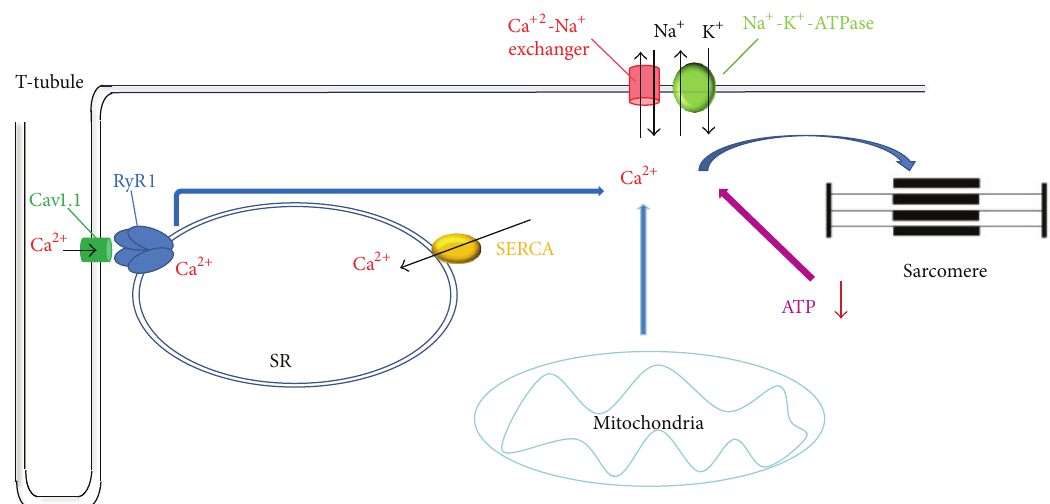
Figure 1: Schematic representation of a skeletal muscle cell and of Ca 2+ and Na + ion fluxes across the sarcolemma and sarcoplasmic reticulum (SR). Activation of Cav1.1 by membrane depolarization causes the RyR1 channel to open and to release Ca 2+ from SR, thus triggering muscle contraction. Ca 2+ concentration is regulated by the Ca 2+ -ATPase membrane pump (SERCA) that sequesters Ca 2+ in the SR and by the Na + - K + -ATPase membrane pump and the Ca 2+ -Na + antiport that exchange Ca 2+ for Na + across thesarcolemma. Regulation of calcium flux may be disrupted at any of these sites. ATP depletion, by consumption during muscle contraction, or reduced ATP production, results in intracellular Ca 2+ increasing, muscle contraction, and continued energy consumption, leading to